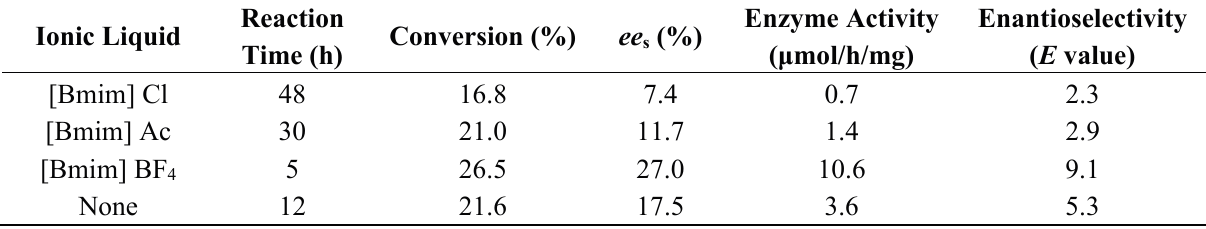
Table 3. Effect of ionic liquids on the enantioselective esterification of α -lipoic acid. Reaction Enzyme Activity Enantioselectivity Conversion (%) ee Ionic Liquid (%) s Time (h) ( μ mol/h/mg) ( E value) [Bmim] Cl 48 16.8 7.4 0.7 2.3 [Bmim] Ac 30 21.0 11.7 1.4 2.9 [Bmim] BF 26.5 27.0 10.6 9.1 4 None 12 21.6 17.5 3.6 5.3 Reaction conditions: Reaction conditions: ( R , S )- α -lipoic acid (2 mmol), CLL (10 mg) co-lyophilized with different ionic liquid (15%, wt %, IL/enzyme), n -octanol (5 mmol) and cyclohexane (10 mL) were